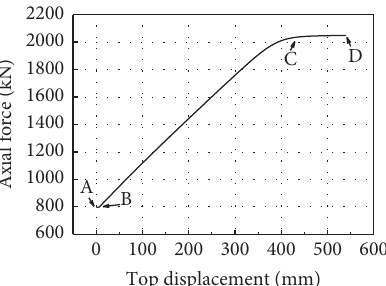
Figure 10: Curve between the axial force of the prestressed tendon and top